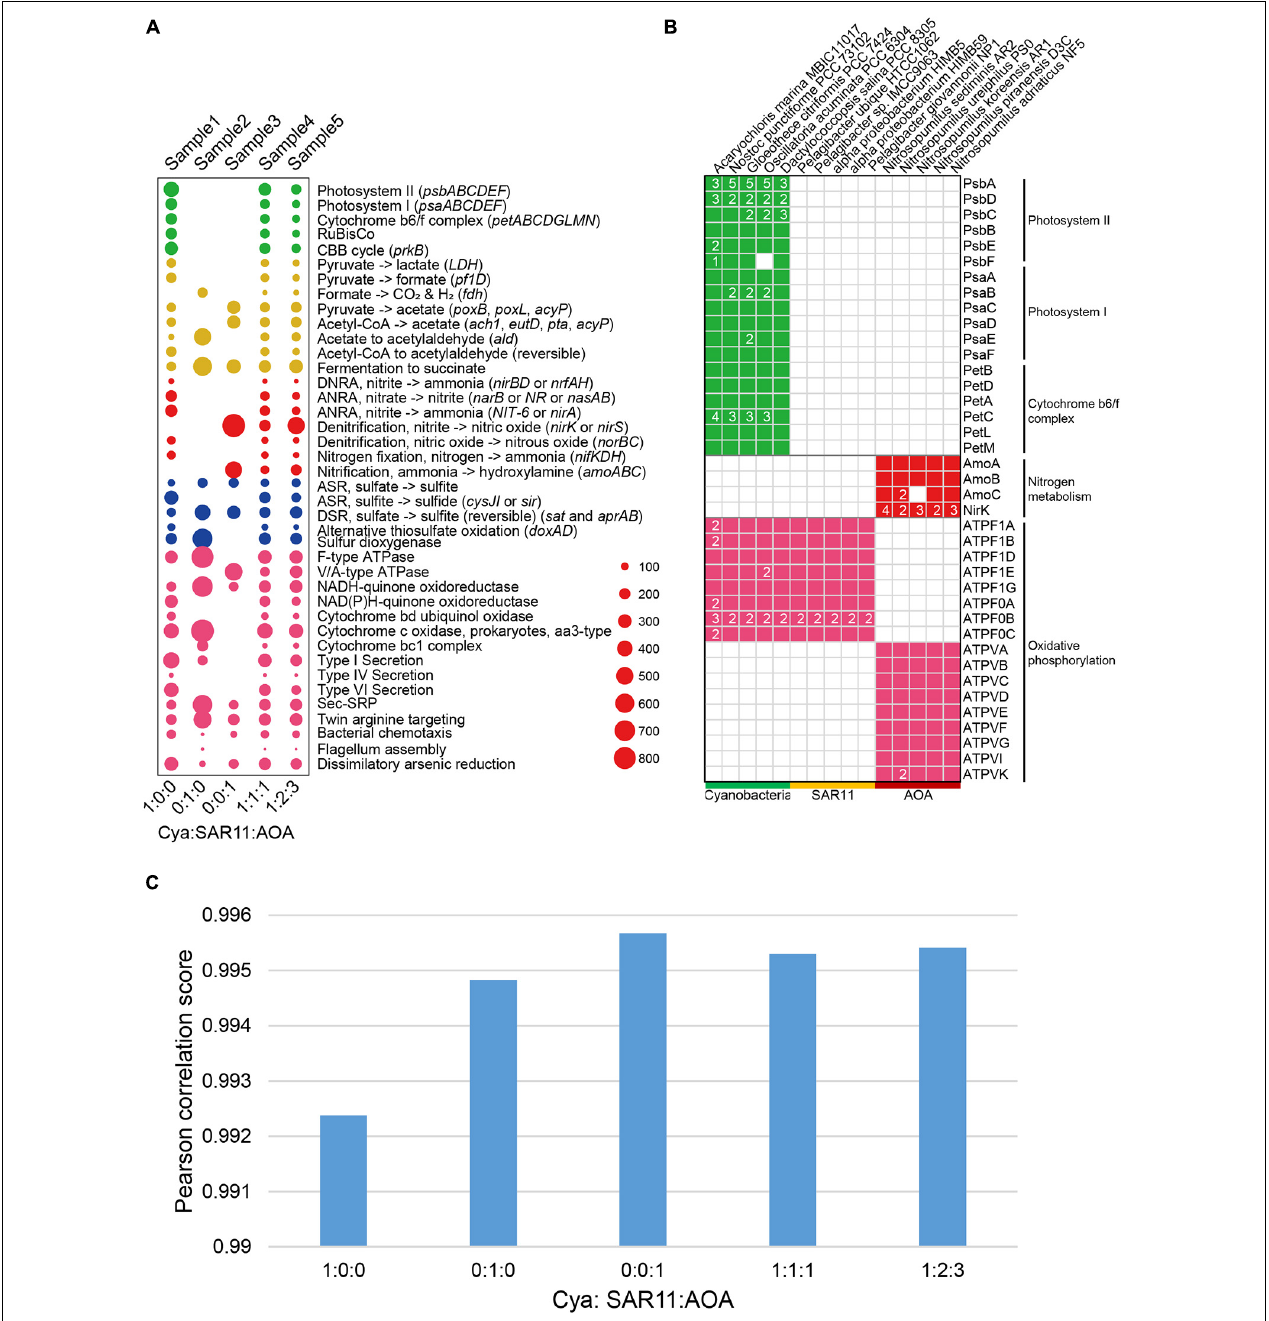
FIGURE 2 | (A) Bubble plots depicting the DiTing result of the relative abundance of pathways in simulated metagenomes. The horizontal axis indicates the relative abundance ratio of Cyanobacteria :SAR11:AOA genomes used in simulated metagenomes. Cya, Cyanobacteria ; SAR11; Pelagibacterales ; AOA. ammonia oxidation archaea; DNRA, dissimilatory nitrate reduction to ammonium; ANRA, assimilatory nitrate reduction to ammonium; ASR; assimilatory sulfate reduction; DSR; dissimilatory sulfate reduction. (B) Selected genes distributed among 15 genomes used to simulate metagenomes. 15 genomes were divided into three groups ( Cyanobacteria , SAR11 and AOA). The genes were annotated by KofamScan. (C) Pearson correlation between gene relative abundance outputted from DiTing and that predicted through the relative abundance of genomes for simulation manually.